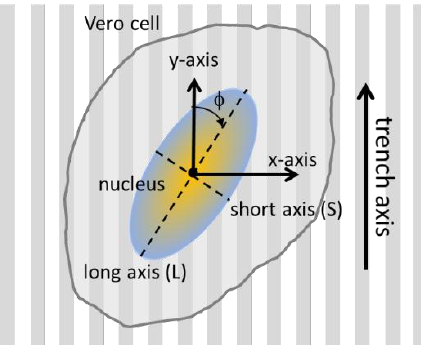
Figure 2. Schematic drawing of a cell adhered on parallel trench comb structure and their orientation parameters. The angle between the cell nucleus long axis and the trench axis is defined as ( φ ). The long and short axial lengths of the nucleus are L and W, respectively.